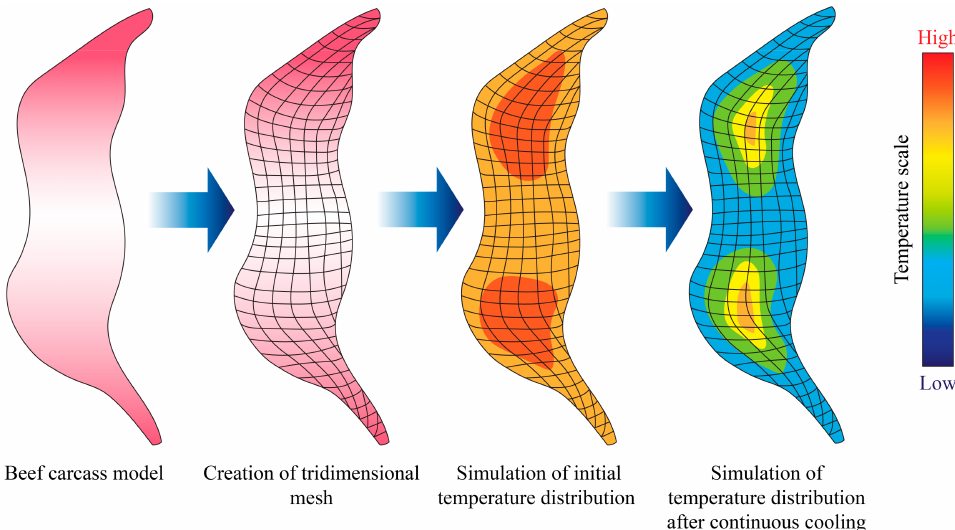
Figure 3. Illustration showing an example of the output obtained from the simulation of cooling or freezing through the solution of the heat transfer differential equations through numerical methods. Adapted from Trujillo and Pham